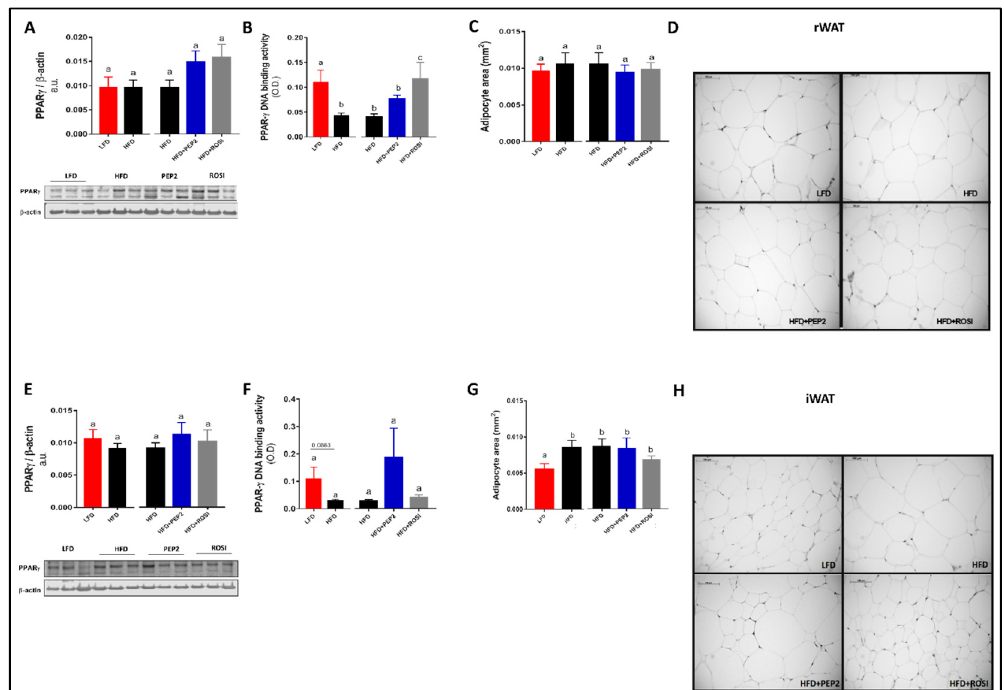
Figure 4. Retroperitoneal white adipose tissue (rWAT) and inguinal white adipose tissue (iWAT) adipogenesis markers in tissues harvested from mice treated with Peptide 2 (Protocol 2). ( A ) PPAR γ